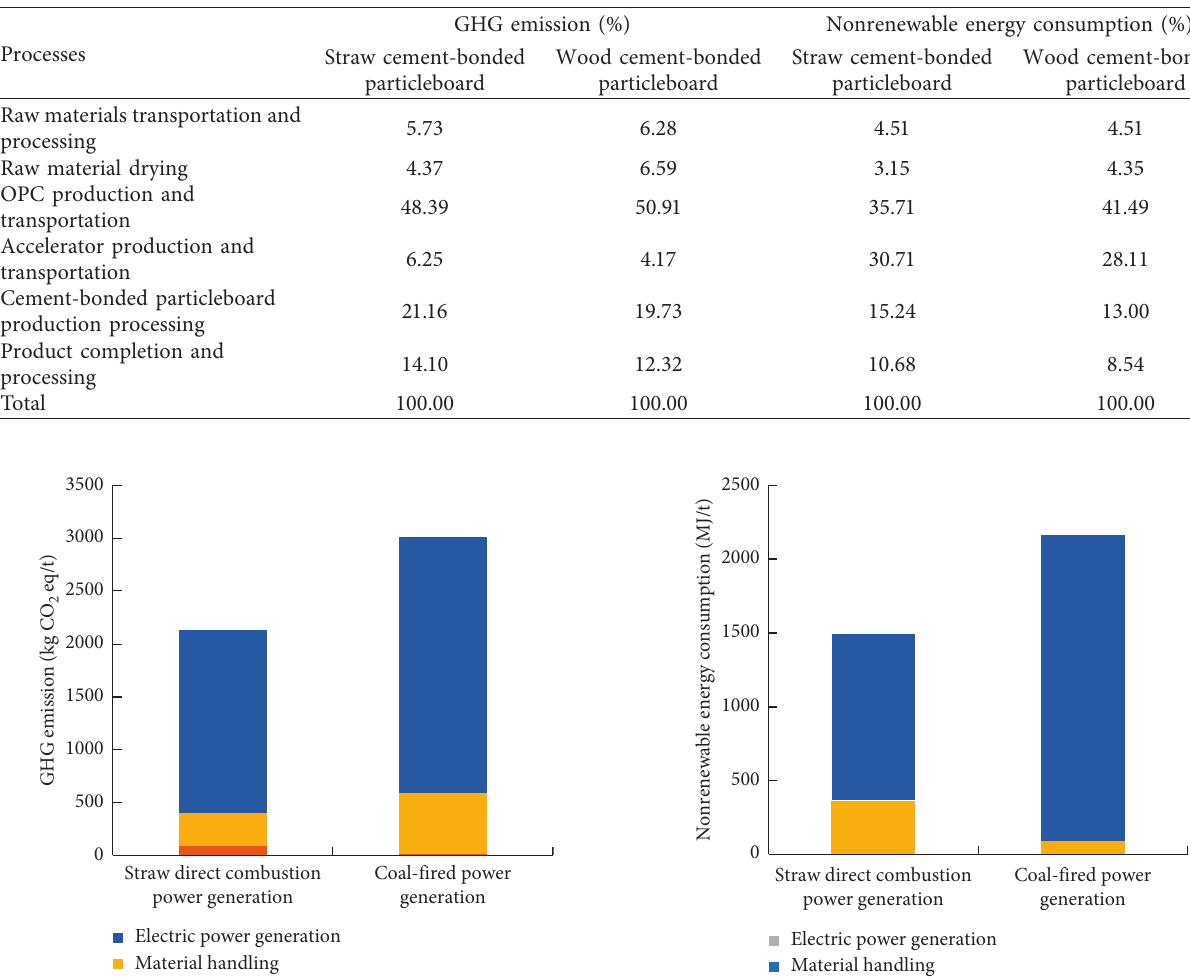
Table 10: Comparative contribution to the production of straw and wood cement-bonded particleboard.